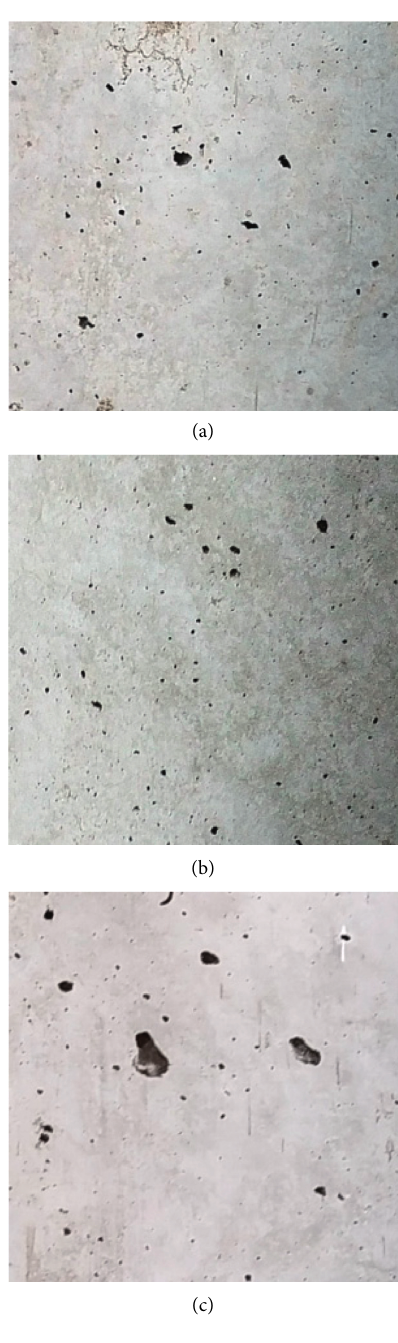
Figure 1: Concrete surface